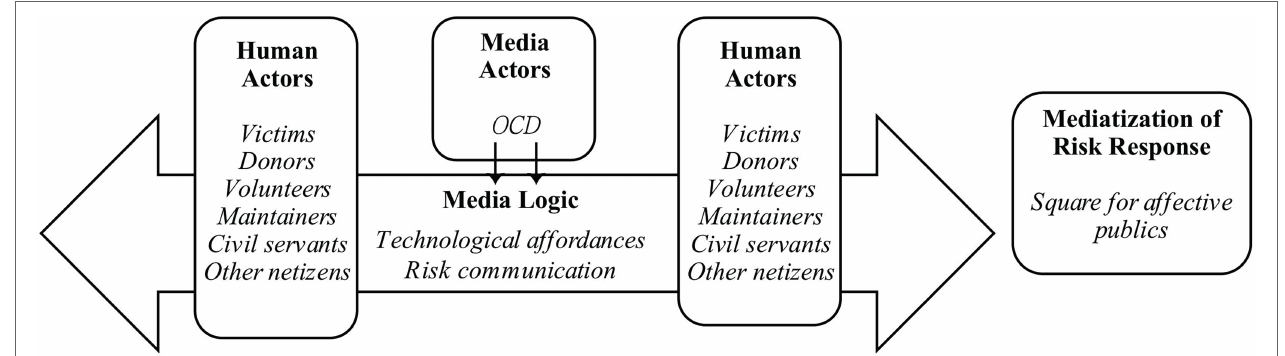
FIGURE 1 | The mediatization of risk response through online collaborative